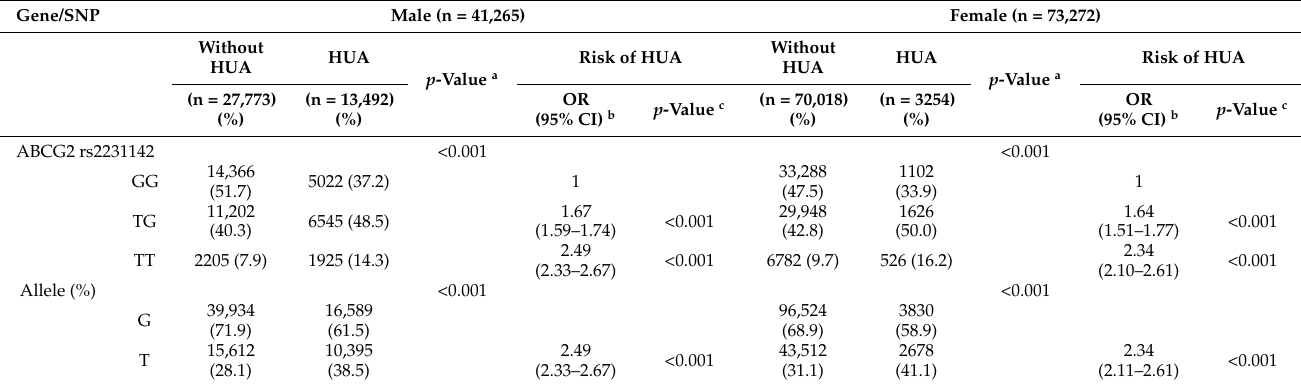
Table 2. Genotypes and allele frequencies of ABCG2 rs2231142 and risk of hyperuricemia in the study population.